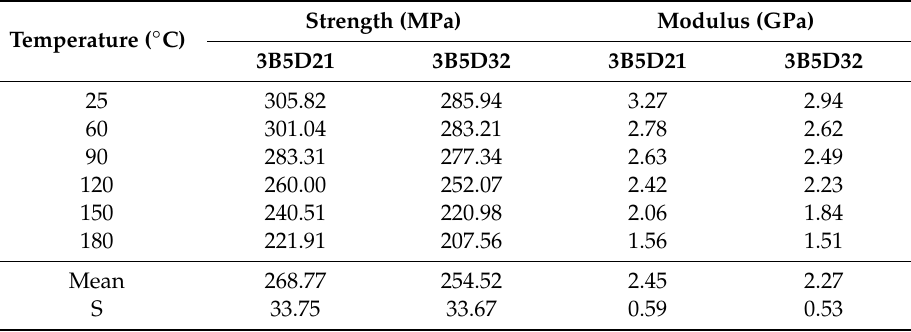
Table 2. The strength and modulus of